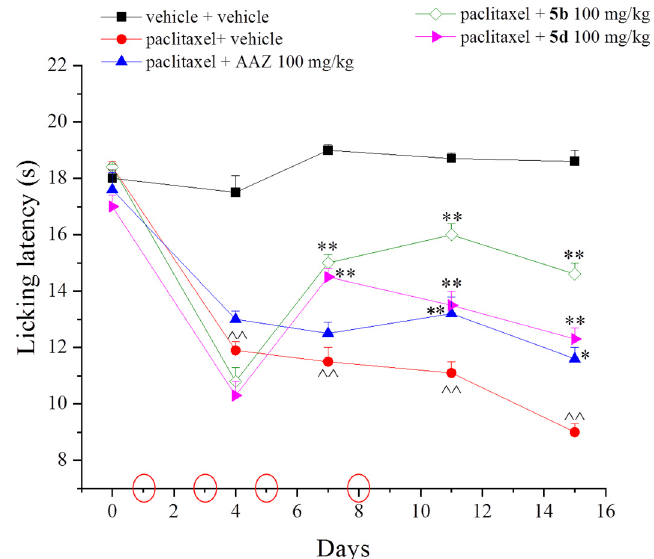
Figure 2. Effect of repeated CAI treatment on pain behavior induced by paclitaxel. Sensitivity to a non-noxious thermal stimulus was measured by the Cold plate test. Paclitaxel (2.0 mg/kg, i.p.) was administered on four days, 1, 3, 5, and 8, circled in red in the figure. Starting from the first day of paclitaxel injection and until the end of the experiment, 5b and 5d and AAZ were daily per os administered at 100 mg/kg. Assessment of cold allodynia was performed on days 4, 7, 11, and 15, 24 h after the last treatment. Results are expressed as the mean ± S.E.M. of eight mice analyzed in two different experimental sets. ^^ p < 0.01 vs. vehicle + vehicle; * p < 0.05 and ** p < 0.01 vs. paclitaxel + vehicle.